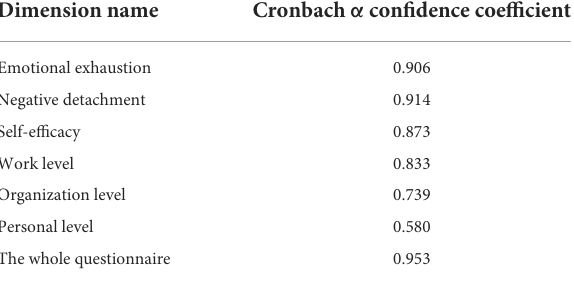
TABLE 1 Cronbach’s Alpha coefficients for subscales and total scales.